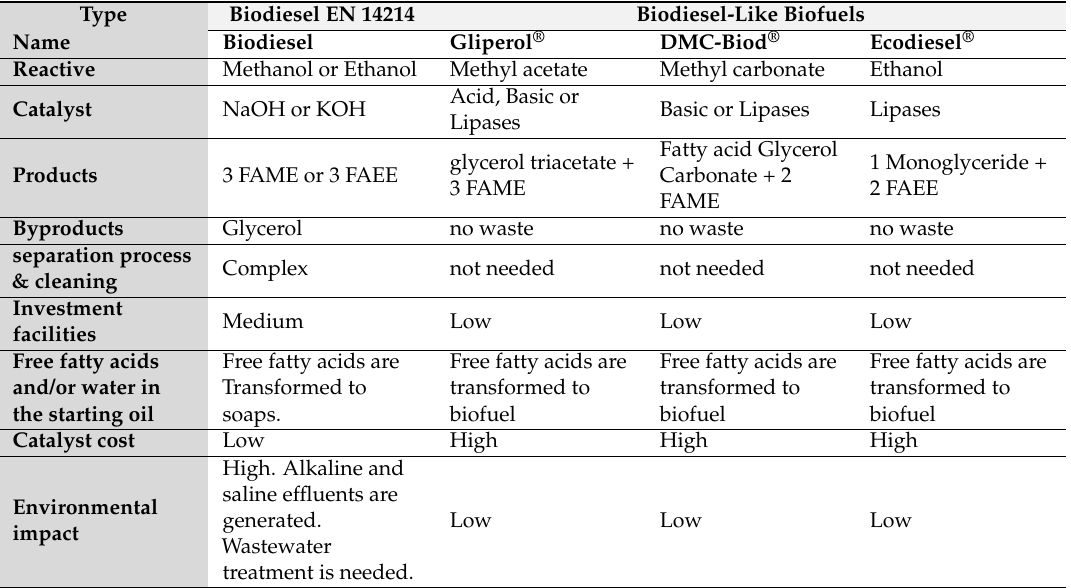
Table 2. Schematic comparison of the main characteristics of the different technologies available to produce renewable liquid fuels, from vegetable